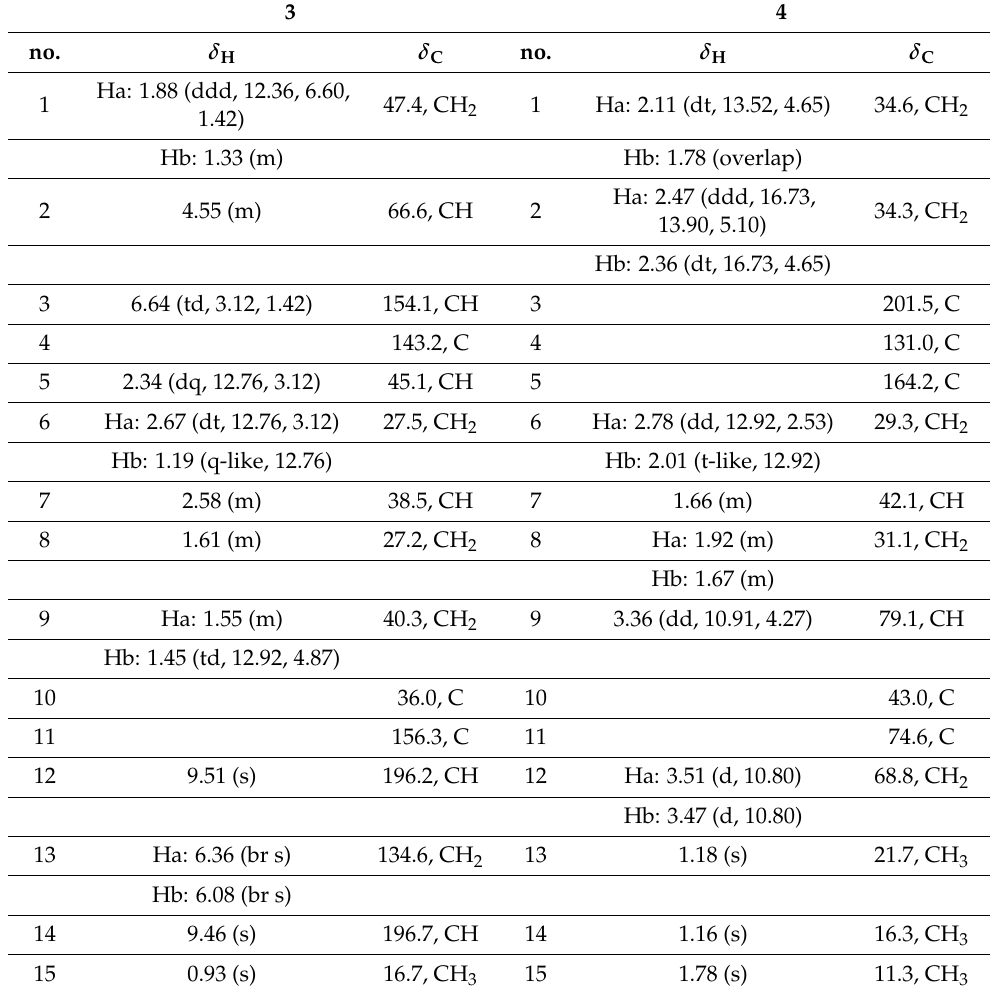
Table 2. 1 H (600 MHz) and 13 C (150 MHz) NMR data of 3 and 4 in